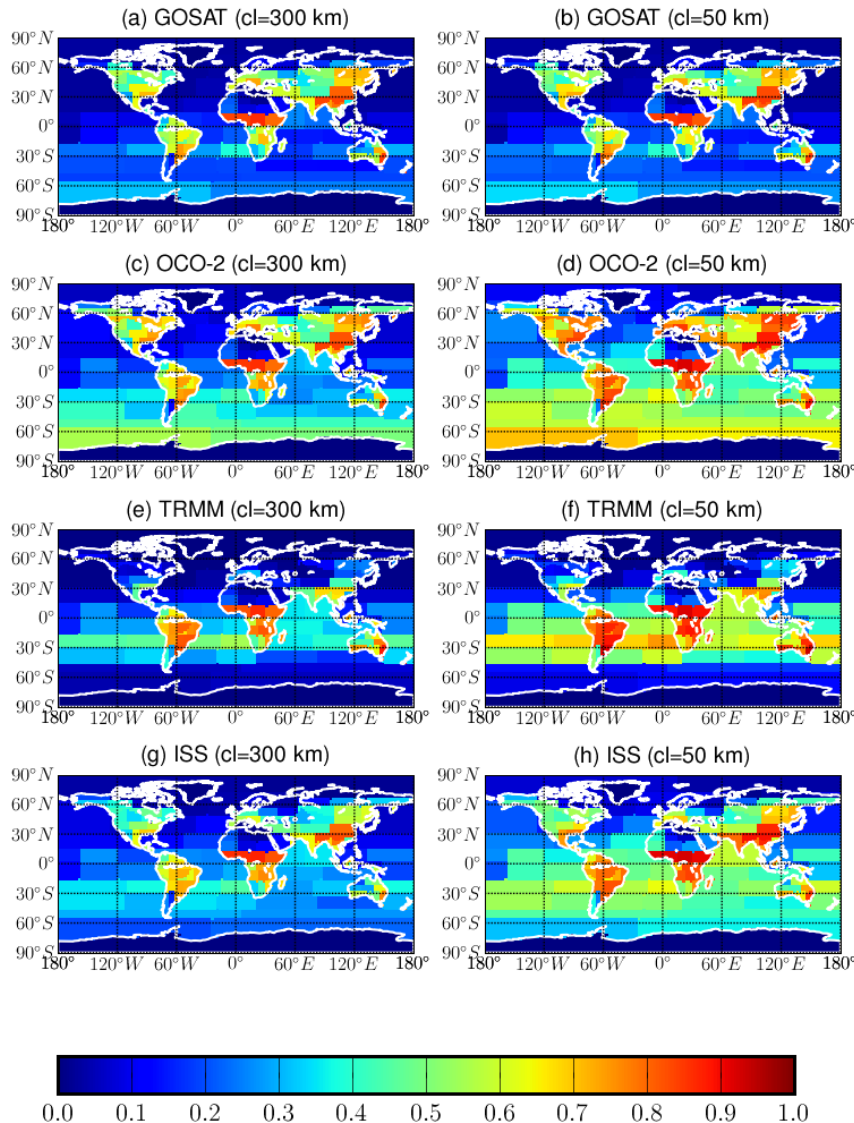
Fig. 5. Same as Fig. 4 but here we consider only glint measurements and include a spatial measurement and model error correlation length of 300 km (left panels) and 50 km (right panels).